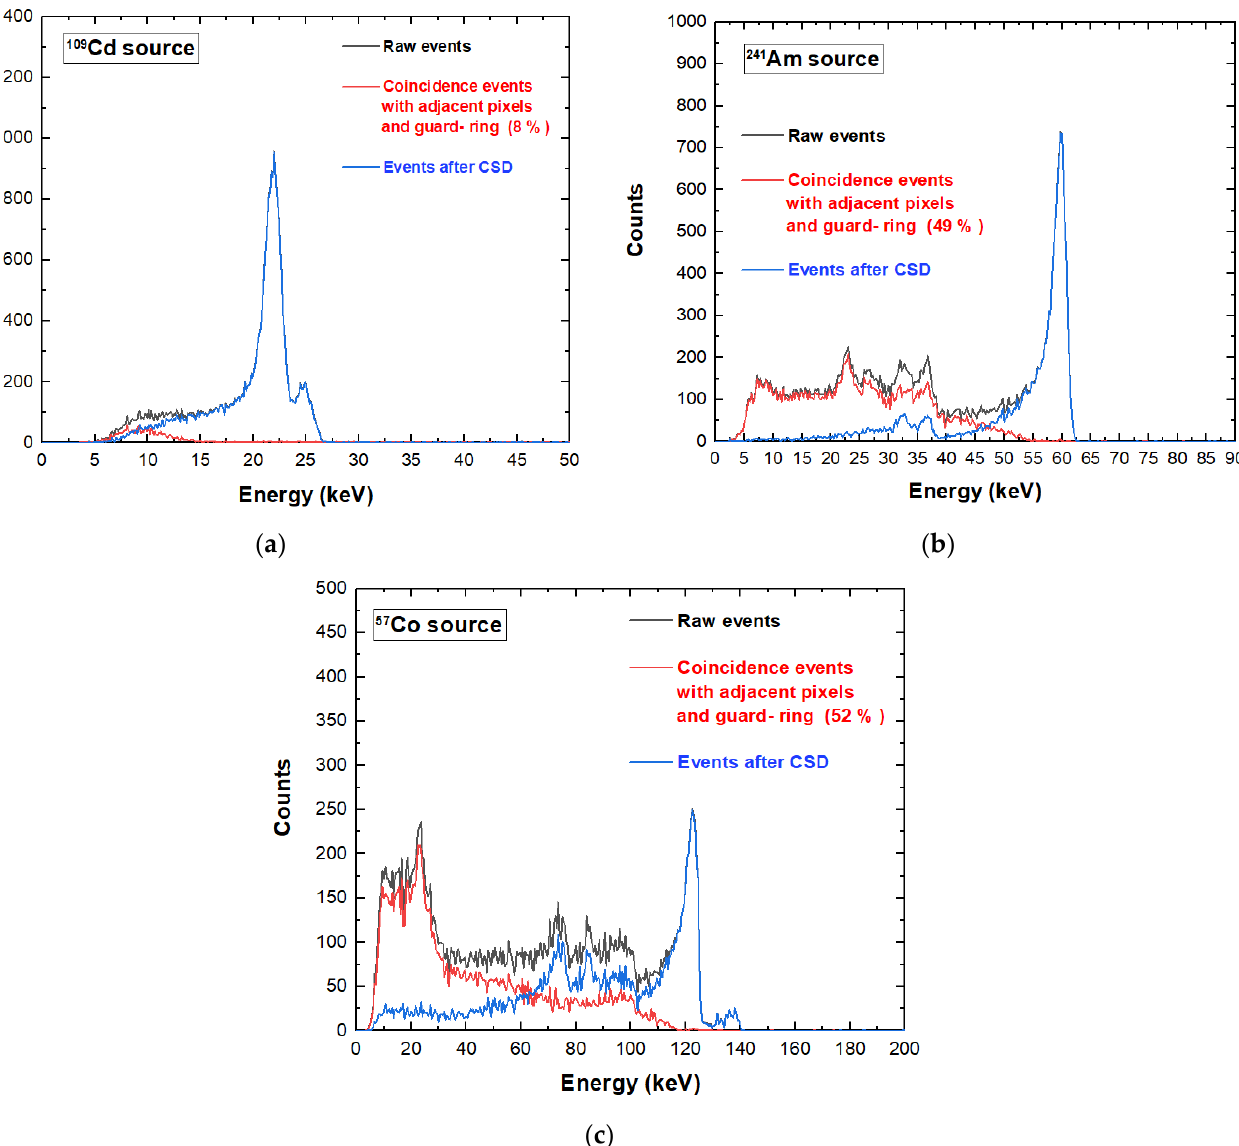
Figure 8. Charge sharing measurements of a tested pixel under ( a ) 109 Cd, ( b ) 241 Am and ( c ) 57 Co sources. The blue lines represent the uncollimated energy spectra after charge sharing discrimination (CSD). The raw spectra (black line) of all events and the spectra of the coincidence events with the two adjacent pixels and the internal guard-ring (red line) are also shown.